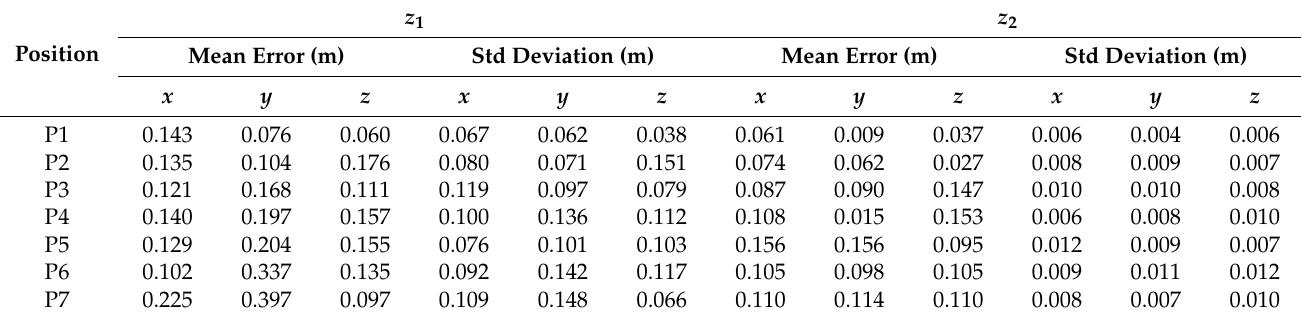
Figure 14. Experimental results for the tested points P1–P7 for both heights, z 1 = 1.35 m on the left ( a – e ) and z 2 = 1.93 m on the right ( f – j ): successively, 3D representation of clouds of points; Y–X projections; Z–X projections; Z–Y projections; and experimental CDFs for each point after EKF fusion ( σ = 0.2 m). Table 12. Mean errors and standard deviations for three ULPSs and a single EKF ( σ w = 0.2 m).